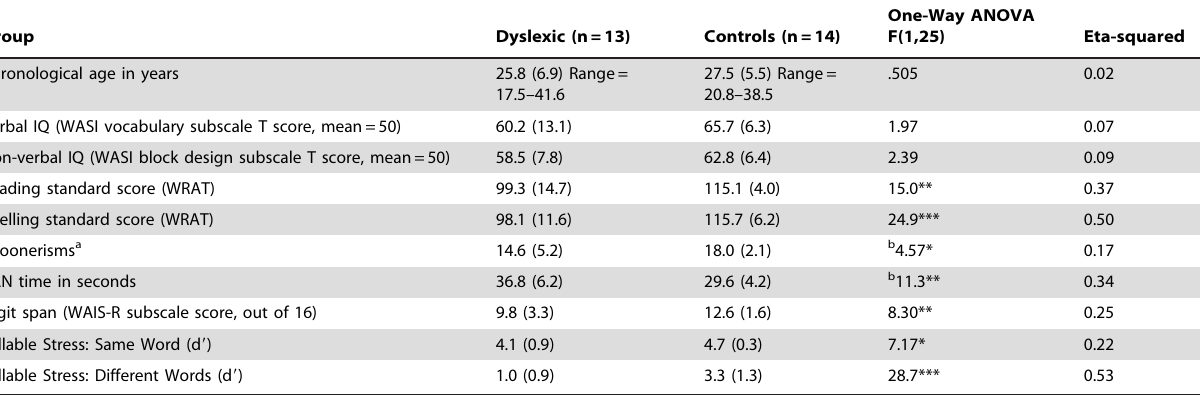
Table 1. Participant